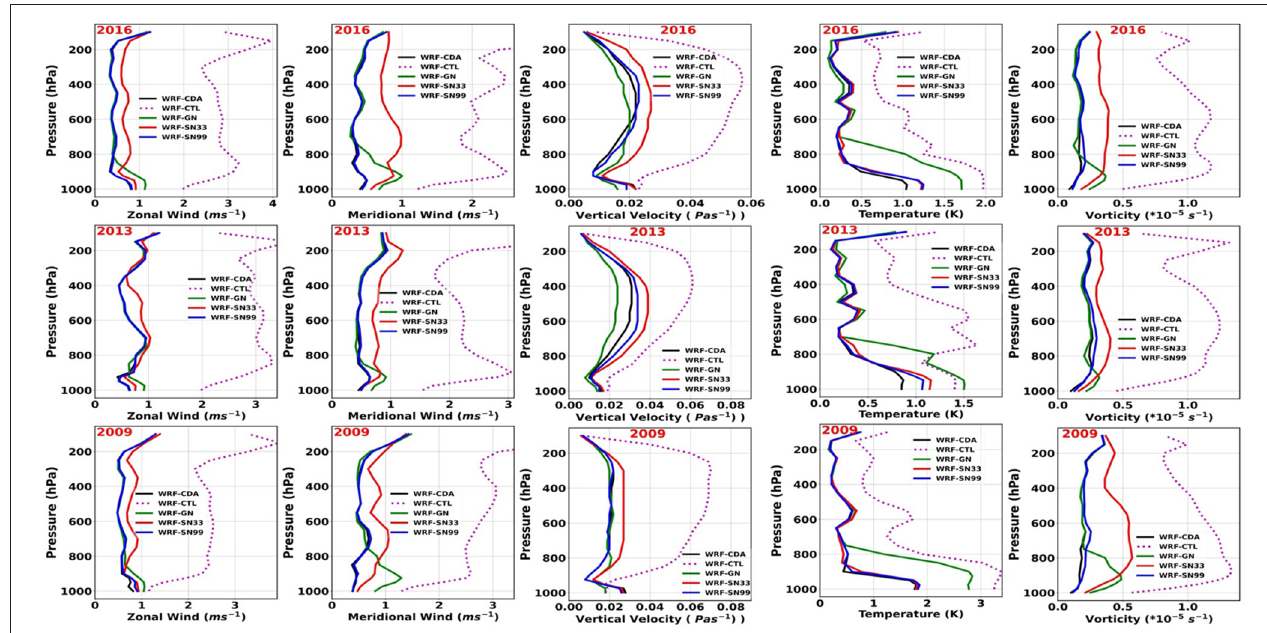
FIGURE 10 | The root-mean-square-error computed for vertical profiles of different atmospheric variables from ERA5 and with different model simulations. The first column is for zonal wind, second column is for meridional wind, third column is for vertical wind, fourth column is for temperature, fifth column is for specific humidity, and sixth column is for relative vorticity. The first row is for normal, second row is for excess, and third row is for drought Indian Summer Monsoon seasons.